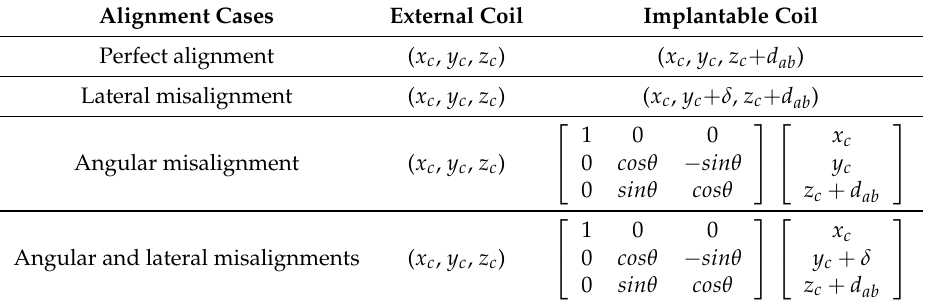
Table 1. The implantable coil under perfect and misalignment cases with respect to external coil